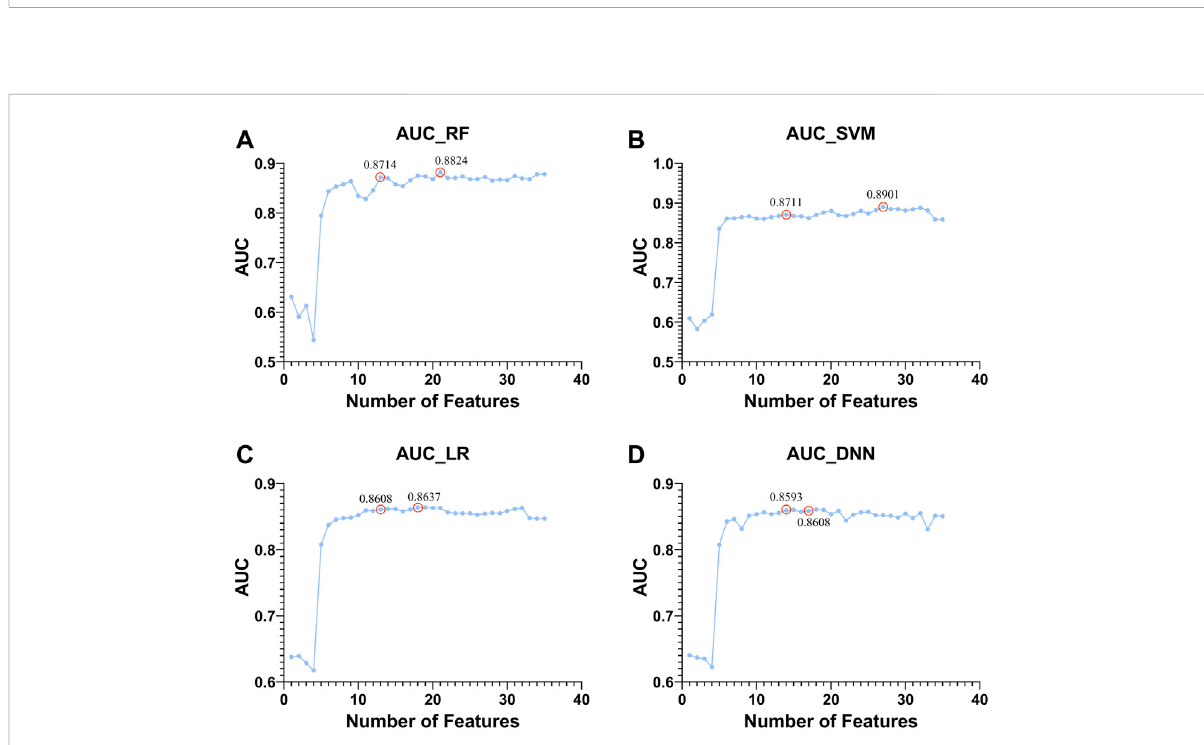
FIGURE 9 Top1toTop50featurestoclassifywhethersubjectsaresickornotandshowsthetrendofincreasingAUCwiththefeaturesused.Theclassi fi ers used by (A – D) . RF, SVM, LR, and DNN,